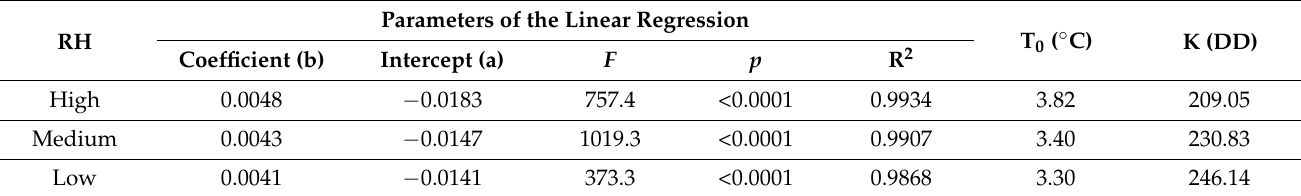
Table 2. The linear regression parameters and the calculated values of the minimum development threshold (T 0 ) and thermal constant (K) for Hypera postica eggs. Parameters of the Linear RH